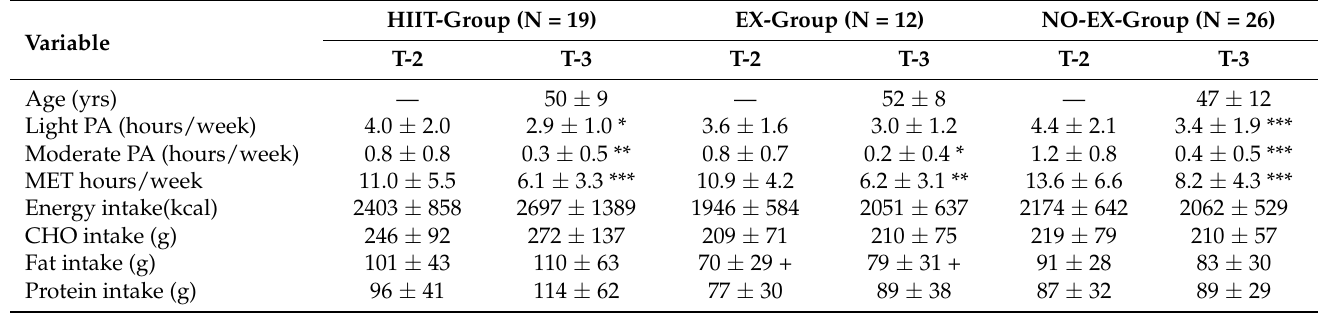
Table 4. Mean values and standard deviations (SD) of participants’ (N = 57) age at follow-up (T-3), physical activity and nutritional intakes prior to the post-intervention (T-2) and follow-up examination (T-3).